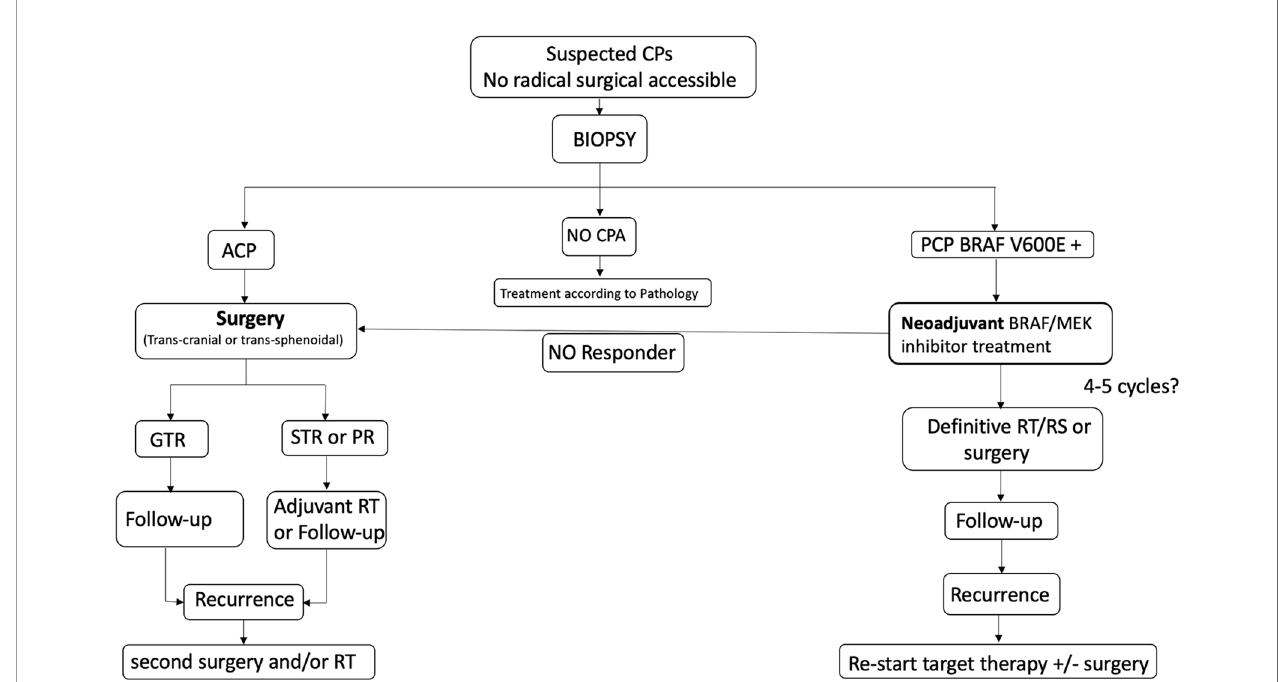
FIGURE 3 | Proposed management algorithm in case of Ventricular and Infundibulo-tuberal CPA which are not good candidate for a safe radical resection. CPs, Craniopharyngioma; ACP, Adamantinomatous CPA; PCP, Papillary CPs; RT, radiotherapy; RS,